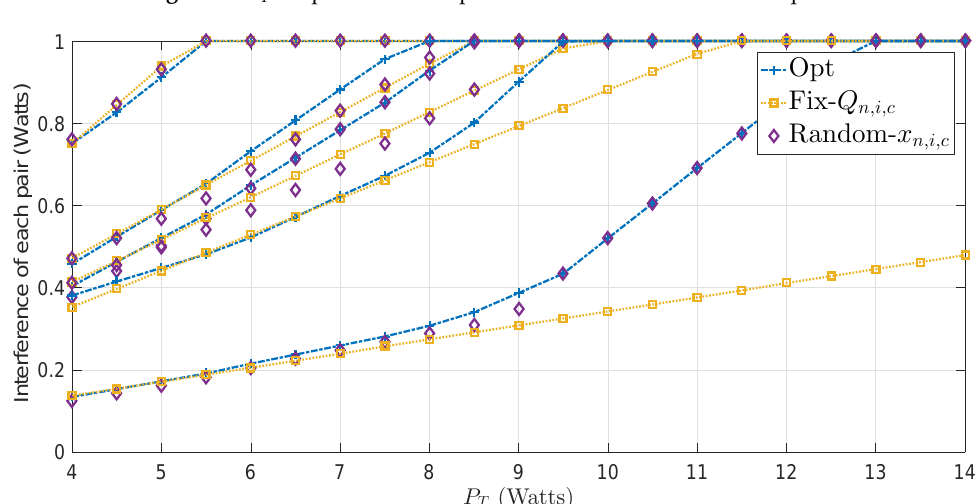
Figure 4. Effect of increasing P T on the interference generated by each user pair in the